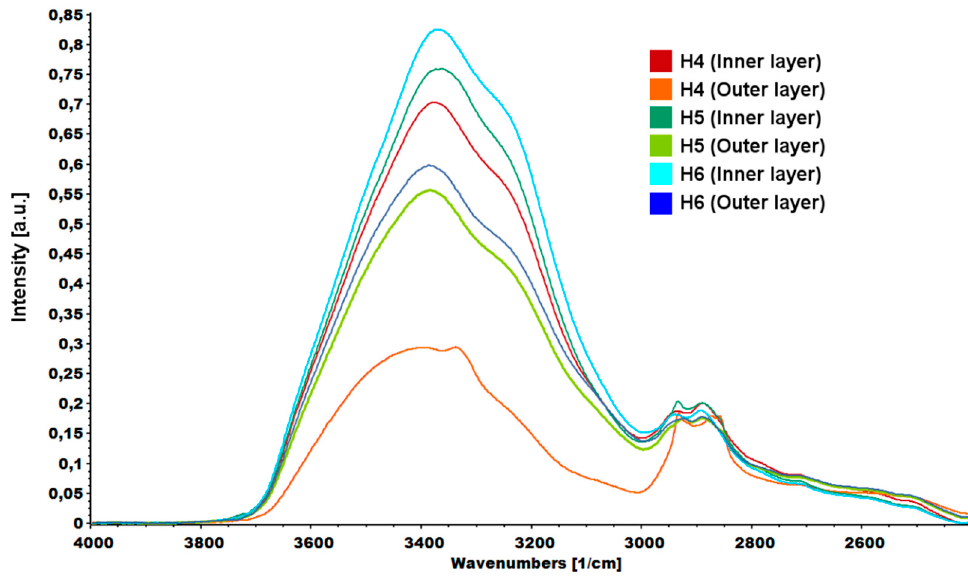
Figure 10. FTIR spectrum of hydrogels (H4: chitosan (CS) / graphene oxide (GO) / hydroxyapatite (HAp); H5: CS / poly(ethylene glycol) grafted graphene oxide / HAp; H6: CS / reduced graphene oxide / HAp) peaks assigned to –OH vibrations.